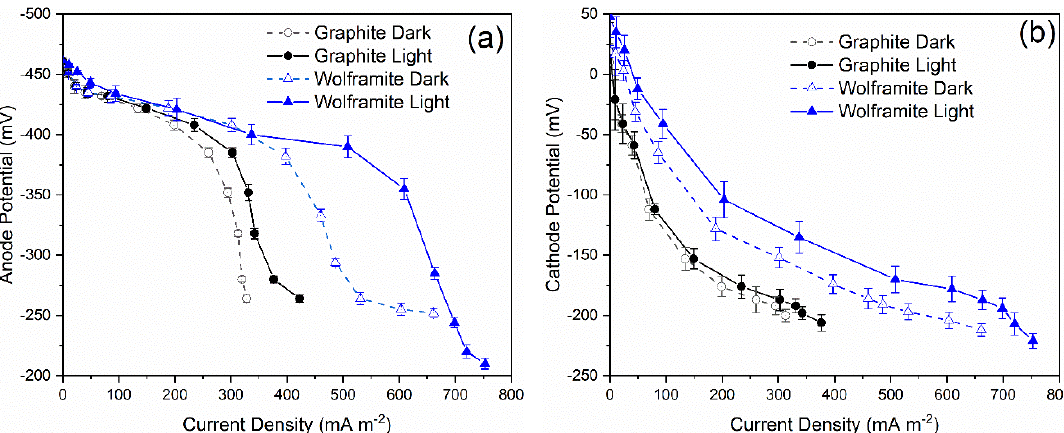
Figure 6. Anode potential curves ( a ) and cathode potential curves ( b ) with natural wolframite-coated graphite cathodes and bare graphite cathodes under dark/light conditions.